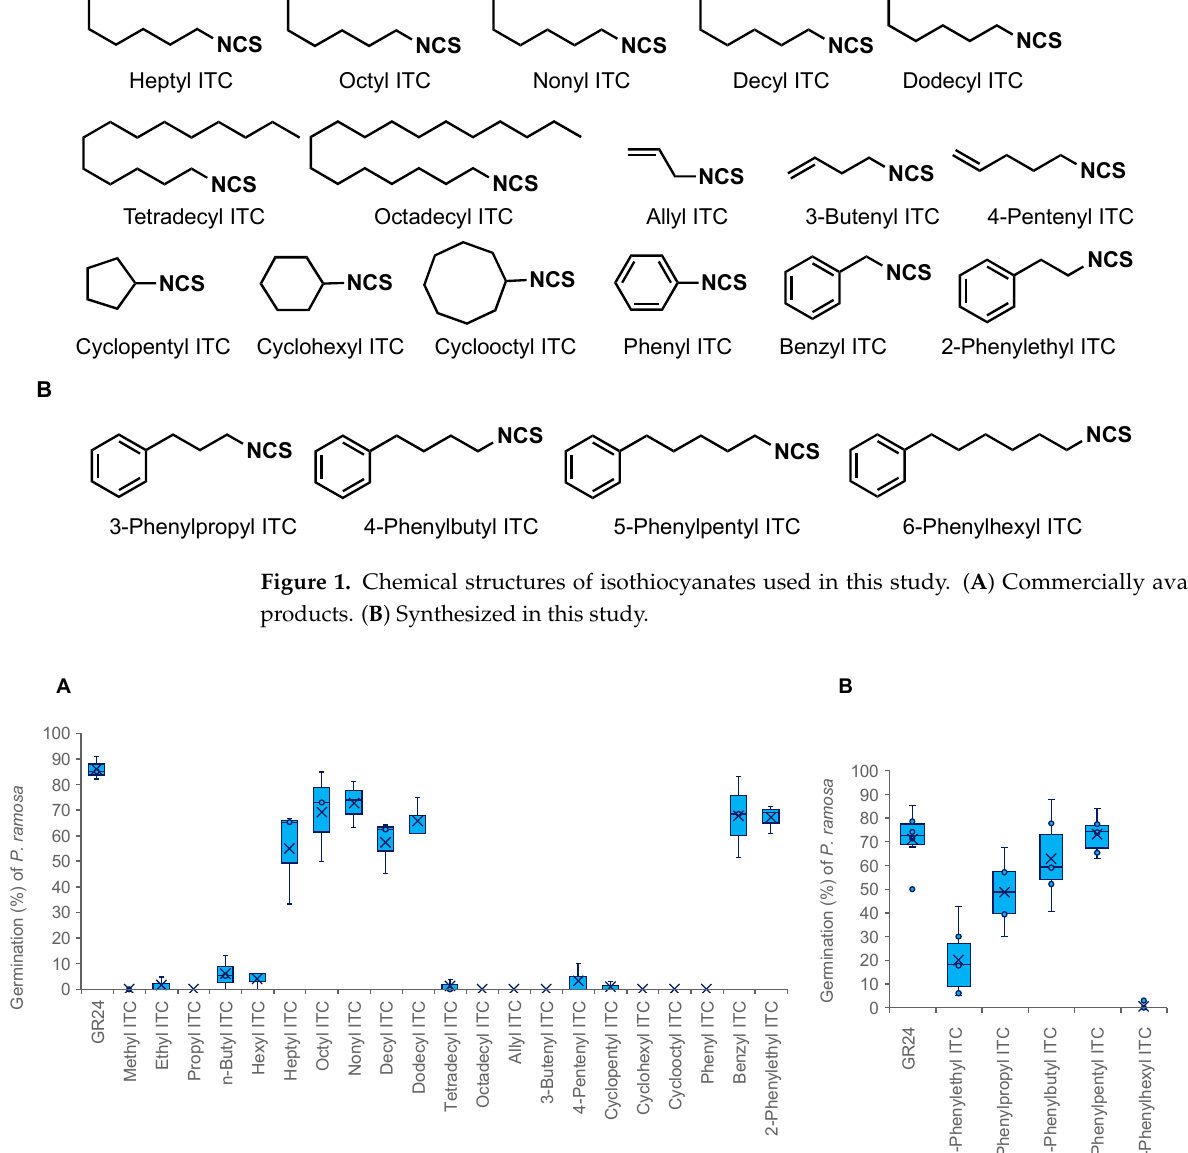
Figure 2. Germination stimulation activities of ITCs on P. ramosa seeds. The activities were examined at 10 − 6 M ( A ) and 10 − 8 M ( B ). The box represents the interquartile range, whiskers represent the maximum and minimum values, the middle indicates the median, and the x within the box represents the mean (A, n = 3; B, n = 6).